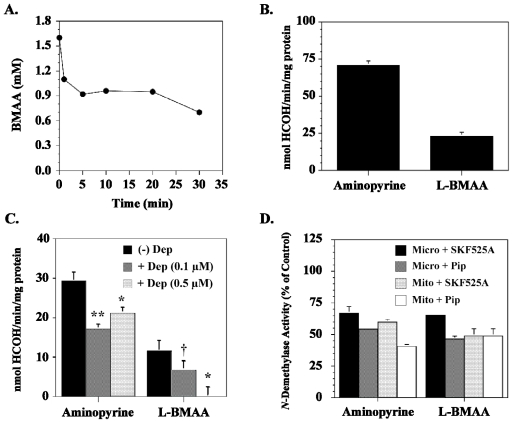
Metabolism of L-BMAA by the brain cytochrome P-450-dependent N-demethylase. (A) Disappearance of L-BMAA after incubation with rat cerebral microsomes 1; (B) Metabolism of L-BMAA by crude microsomes derived from mouse cortical explants 2; (C) Effect of the N-demethylase inhibitor deprenyl on the metabolism of L-BMAA by rat cerebral microsomes 3; (D) Effect of the cytochrome P450 inhibitors SKF525A and piperonyl butoxide on the metabolism of L-BMAA by rat cerebral microsomes and mitochondria 4. Graphs derived from Kisby et al. [43] and unpublished data.1 Cerebral microsomes were prepared from adult Sprague-Dawley rats (n = 2) according to [44], diluted with buffer to a final concentration of 10 μg protein/mL and incubated at 37°C with 1.6 mM L-BMAA in the presence of 1.0 mM NADPH. At various time periods, an aliquot (100 μL) was ultrafiltered (10 K MWCO) and the ultrafiltrate analyzed for L-BMAA content by HPLC [45]. L-BMAA disappeared with time, an indication that it was metabolized by cerebral microsomes;2 Explants (n = 15) were sonicated (2 × 10 s) on ice in 500 μl of ice-cold PBS, the homogenate centrifuged (16,000 × g) and an aliquot of the supernatant (crude microsomal fraction) taken for protein determination. The aliquot was incubated with 1.6 mM aminopyrine or L-BMAA and N-demethylase activity determined [44]. Samples were run in triplicate, averaged and the results expressed as nmoles of formaldehyde/min/mg protein ± standard error;3 An aliquot of protein was incubated with 1.6 mM aminopryine or L-BMAA in the presence or absence of 0.1 μM or 0.5 μM deprenyl, an aminopyrine N-demethylase inhibitor [46], and N-demethylase activity determined [44]. Deprenyl had a significant influence on the metabolism of both aminopyrine and L-BMAA and the effect of this inhibitor on L-BMAA metabolism was concentration-dependent;4 An aliquot of microsomal or mitochondrial protein was incubated with 1.6 mM aminopyrine or 1.6 mM L-BMAA in the presence or absence of either 100 μM SKF525A or 500 μMpiperonyl butoxide and N-demethylase activity determined [44]. Results are expressed as % N-demethylase activity relative to controls. The N-demethylase activity of control microsomes and mitochondria were comparable to that previously reported [44]. The N-demethylation of aminopyrine and L-BMAA was inhibited by piperonyl butoxide and SKF525A in both brain microsomes and mitochondria; an indication that L-BMAA is metabolized to formaldehyde by mixed function oxidases. Significantly different from microsomes incubated with aminopyrine or L-BMAA († p < 0.05; * p < 0.01; ** p < 0.001).